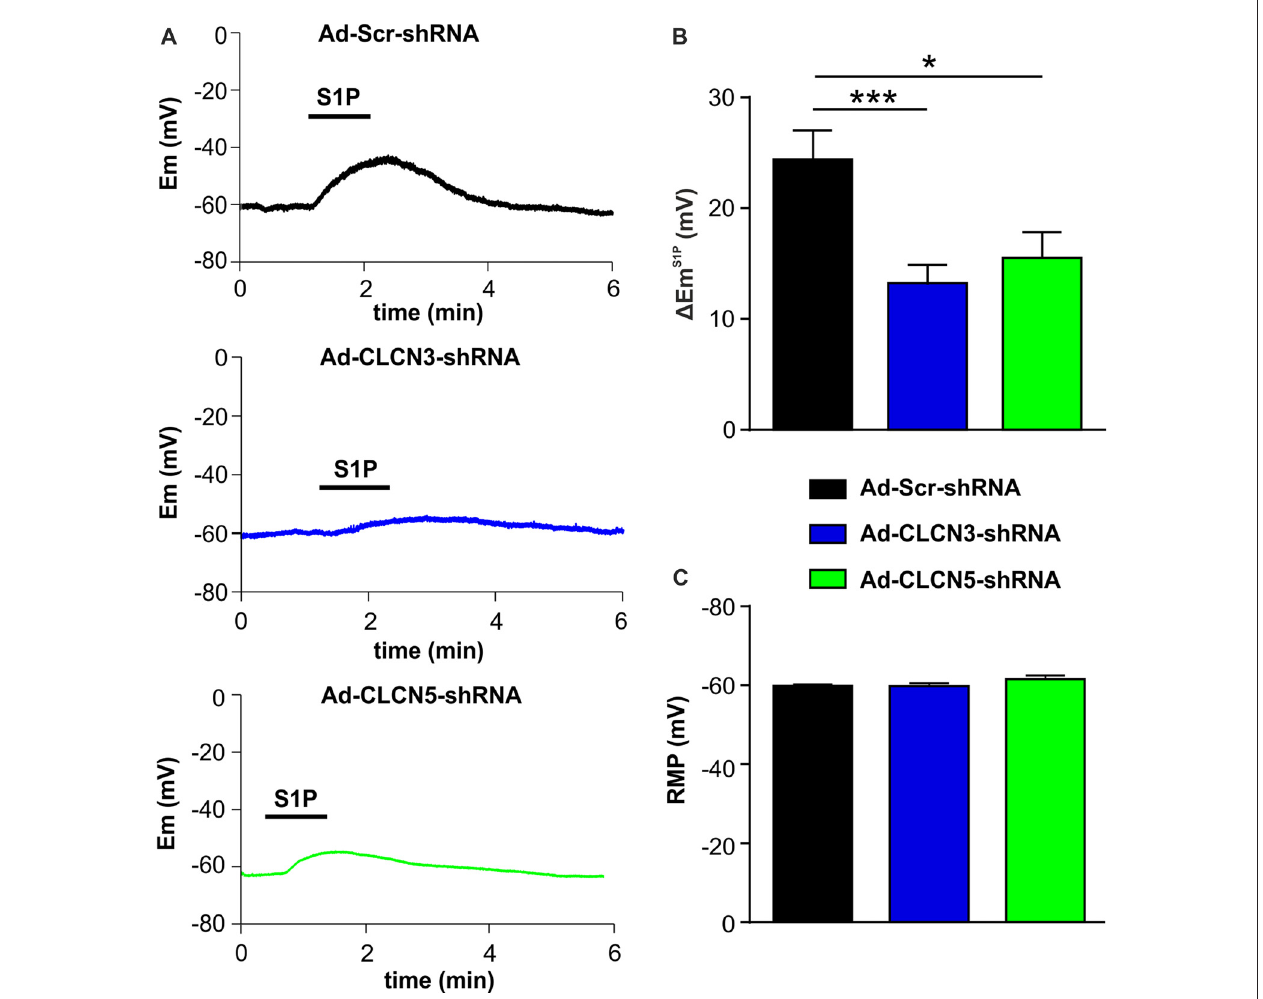
FIGURE 3 | Adenovirus-based shRNA knockdown of CLCN3 or CLCN5 decreases S1P-induced membrane depolarization in sensory neurons. (A) Representative whole-cell current clamp recording of membrane potential evoked by stimulation of S1P (1 µ M, 1 min) from DRG neurons 3 days after adenoviral infection of Ad-Scr-shRNA, Ad-CLCN3-shRNA or Ad-CLCN5-shRNA. (B) The depolarizing effect of S1P was significantly decreased by viral infection of Ad-CLCN3-shRNA or Ad-CLCN5-shRNA (Unpaired t -test, Ad-Scr-shRNA vs. Ad-CLCN3-shRNA, n = 29–35, ∗∗∗ p < 0.001, Ad-Scr-shRNA vs. Ad-CLCN5-shRNA, n = 32–35, ∗ p < 0.05). (C) Bar-chart showing that the resting membrane potential (RMP) was not affected by viral infection of Ad-CLCN3-shRNA or Ad-CLCN5-shRNA (Unpaired t -test, Ad-Scr-shRNA vs. Ad-CLCN3-shRNA, n = 29–35, p > 0.05, Ad-Scr-shRNA vs. Ad-CLCN5-shRNA, n = 32–35, p >